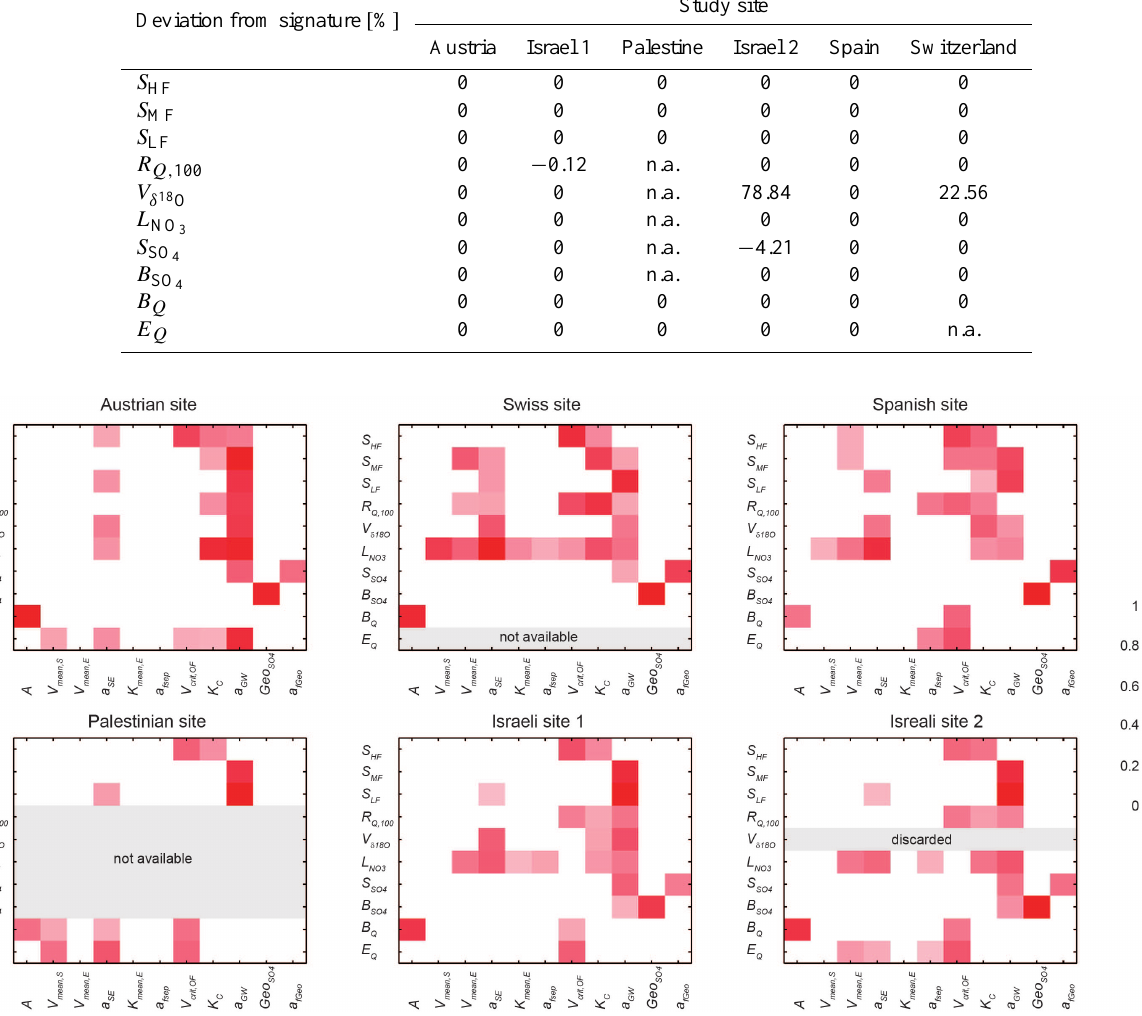
Fig. 4. 2 T of model parameters concerning the system signatures for all study sites (all parameters with 2 T < 0.2 are considered not sensitive and have been